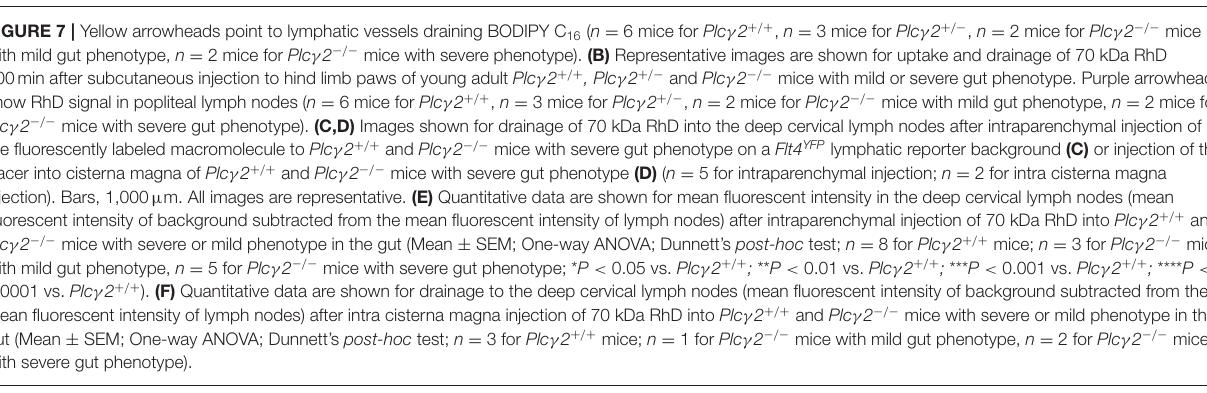
FIGURE 7 | Yellow arrowheads point to lymphatic vessels draining BODIPY C 16 ( n = 6 mice for Plc γ 2 + / + , n = 3 mice for Plc γ 2 + / − , n = 2 mice for Plc γ 2 − / − mice with mild gut phenotype, n = 2 mice for Plc γ 2 − / − mice with severe phenotype). (B) Representative images are shown for uptake and drainage of 70 kDa RhD 100min after subcutaneous injection to hind limb paws of young adult Plc γ 2 + / + , Plc γ 2 + / − and Plc γ 2 − / − mice with mild or severe gut phenotype. Purple arrowheads show RhD signal in popliteal lymph nodes ( n = 6 mice for Plc γ 2 + / + , n = 3 mice for Plc γ 2 + / − , n = 2 mice for Plc γ 2 − / − mice with mild gut phenotype, n = 2 mice for Plc γ 2 − / − mice with severe gut phenotype). (C,D) Images shown for drainage of 70 kDa RhD into the deep cervical lymph nodes after intraparenchymal injection of the fluorescently labeled macromolecule to Plc γ 2 + / + and Plc γ 2 − / − mice with severe gut phenotype on a Flt4 YFP lymphatic reporter background (C) or injection of the tracer into cisterna magna of Plc γ 2 + / + and Plc γ 2 − / − mice with severe gut phenotype (D) ( n = 5 for intraparenchymal injection; n = 2 for intra cisterna magna injection). Bars, 1,000 µ m. All images are representative. (E) Quantitative data are shown for mean fluorescent intensity in the deep cervical lymph nodes (mean fluorescent intensity of background subtracted from the mean fluorescent intensity of lymph nodes) after intraparenchymal injection of 70 kDa RhD into Plc γ 2 + / + and Plc γ 2 − / − mice with severe or mild phenotype in the gut (Mean ± SEM; One-way ANOVA; Dunnett’s post-hoc test; n = 8 for Plc γ 2 + / + mice; n = 3 for Plc γ 2 − / − mice with mild gut phenotype, n = 5 for Plc γ 2 − / − mice with severe gut phenotype; * P < 0.05 vs. Plc γ 2 + / + ; ** P < 0.01 vs. Plc γ 2 + / + ; *** P < 0.001 vs. Plc γ 2 + / + ; **** P < 0.0001 vs. Plc γ 2 + / + ). (F) Quantitative data are shown for drainage to the deep cervical lymph nodes (mean fluorescent intensity of background subtracted from the mean fluorescent intensity of lymph nodes) after intra cisterna magna injection of 70 kDa RhD into Plc γ 2 + / + and Plc γ 2 − / − mice with severe or mild phenotype in the gut (Mean ± SEM; One-way ANOVA; Dunnett’s post-hoc test; n = 3 for Plc γ 2 + / + mice; n = 1 for Plc γ 2 − / − mice with mild gut phenotype, n = 2 for Plc γ 2 − / − mice with severe gut